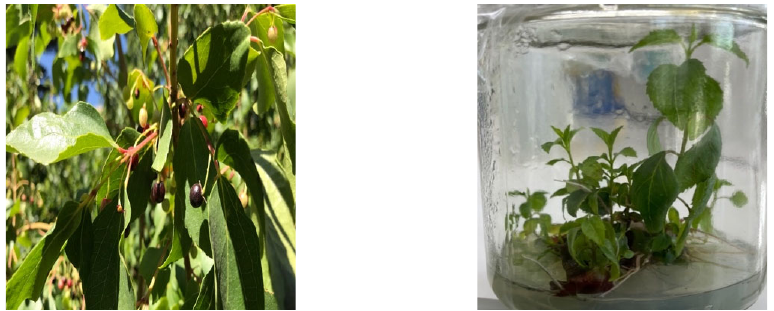
Figure 1. Fruits and in vitro plants of Aristotelia chilensis (Maqui). Table 1. Content of total anthocyanins, total phenols, DPPH (IC 50 ) of aqueous extracts of fruit and in vitro plant of A. chilensis . Mean ± standard deviation. Significant differences are denoted by dif ‐ ferent letters, ( p < 0.05) .